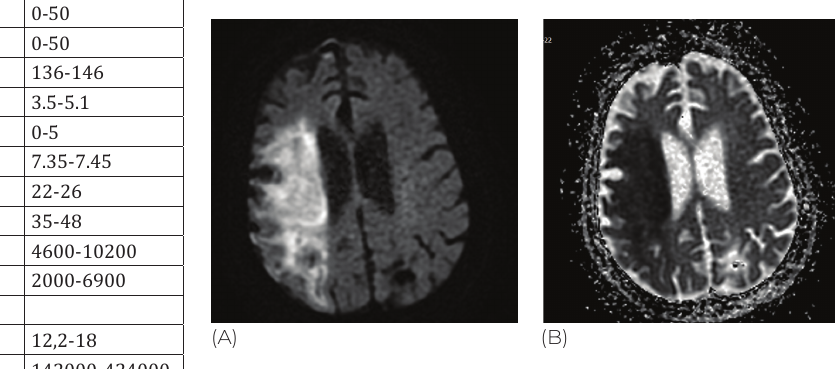
Figure 3. Diffusion image in the same CT section (A) and in the ADC sequences (B). Diffusion reduction was spotted and compatible with acute ischemia in the area fed by the right middle cerebral artery.